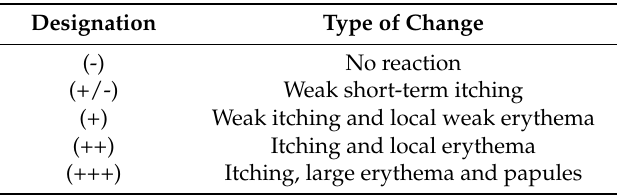
Table 6. Skin assessment by a